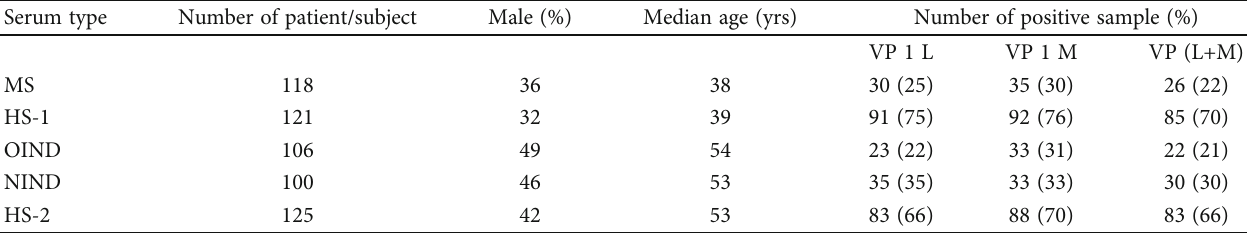
Table 2: Prevalence of immunoglobulin G antibodies reacting to BKPyV viral protein 1 (VP1) mimotopes L and M. Serum